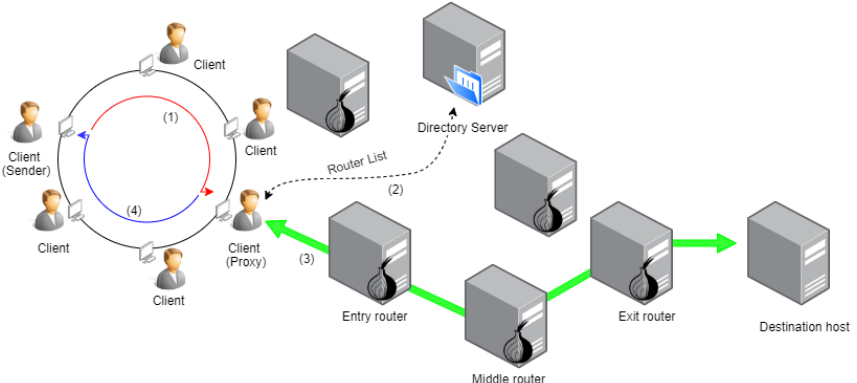
Figure 7. Communication